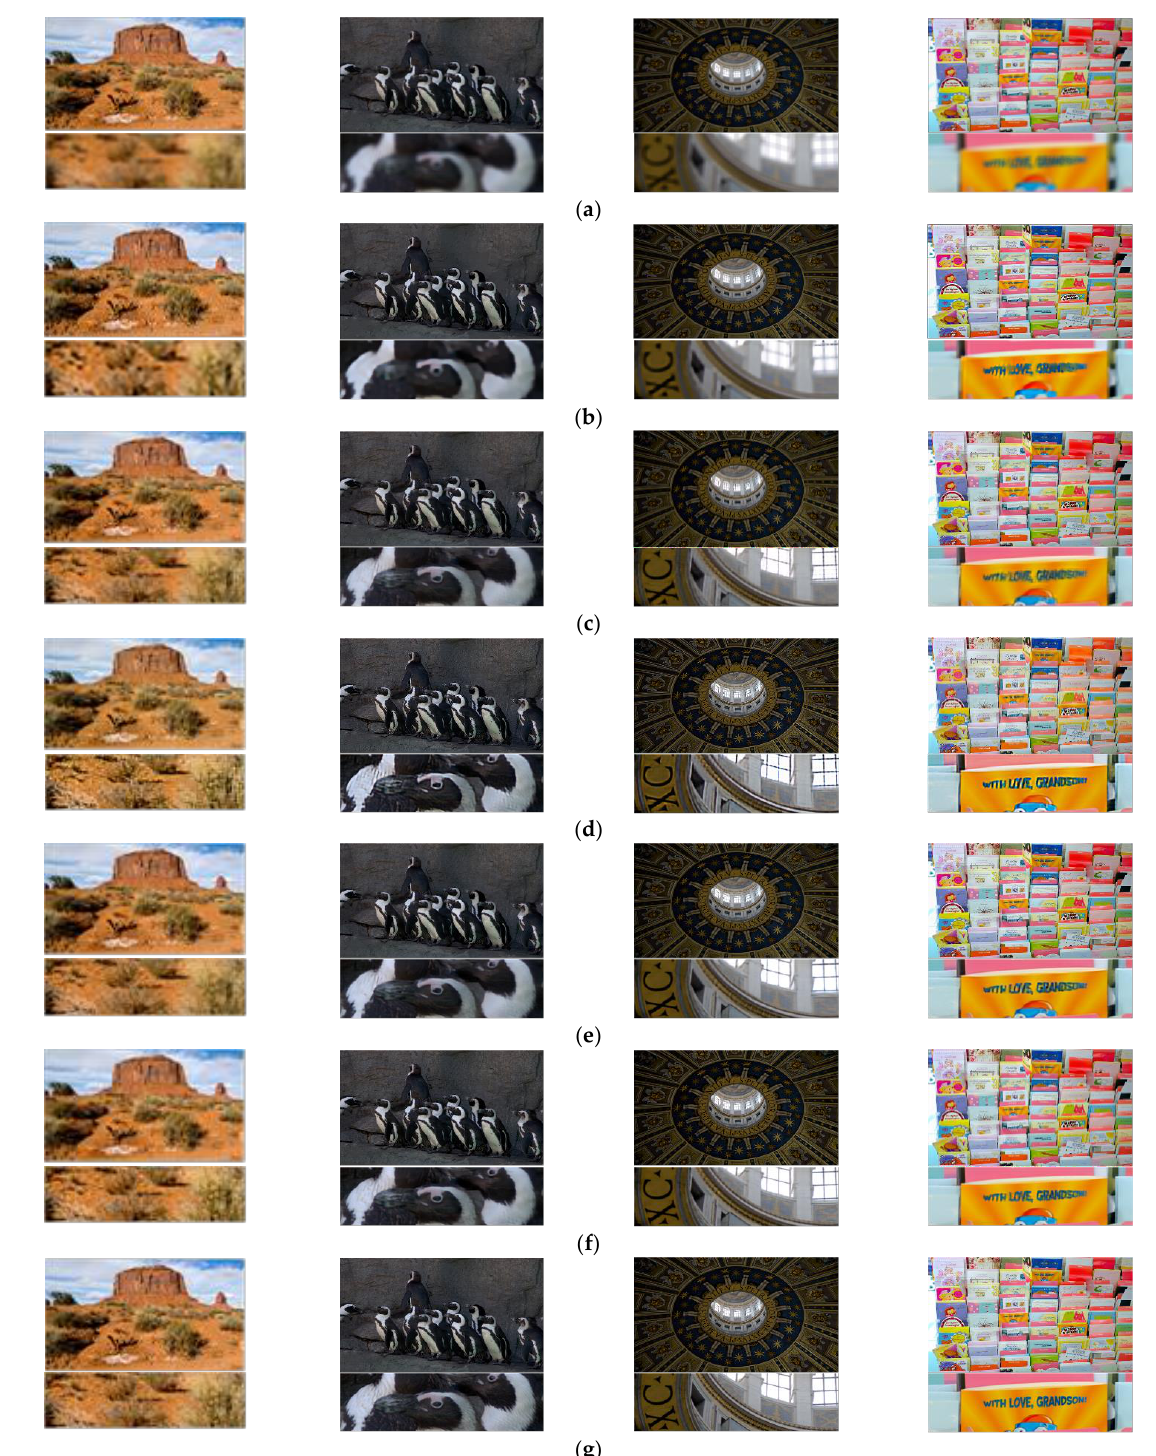
Figure 6. The results comparison using different restoring methods based on simulation dataset: ( a ) Original blurry images; ( b ) Non-uniform aberration deblurring results; ( c ) Unet restoring results; ( d ) FOV-GAN restoring results; ( e ) DeblurGAN-v2 restoring results; ( f ) Our proposed RRG-GAN restoring results; ( g ) The ground